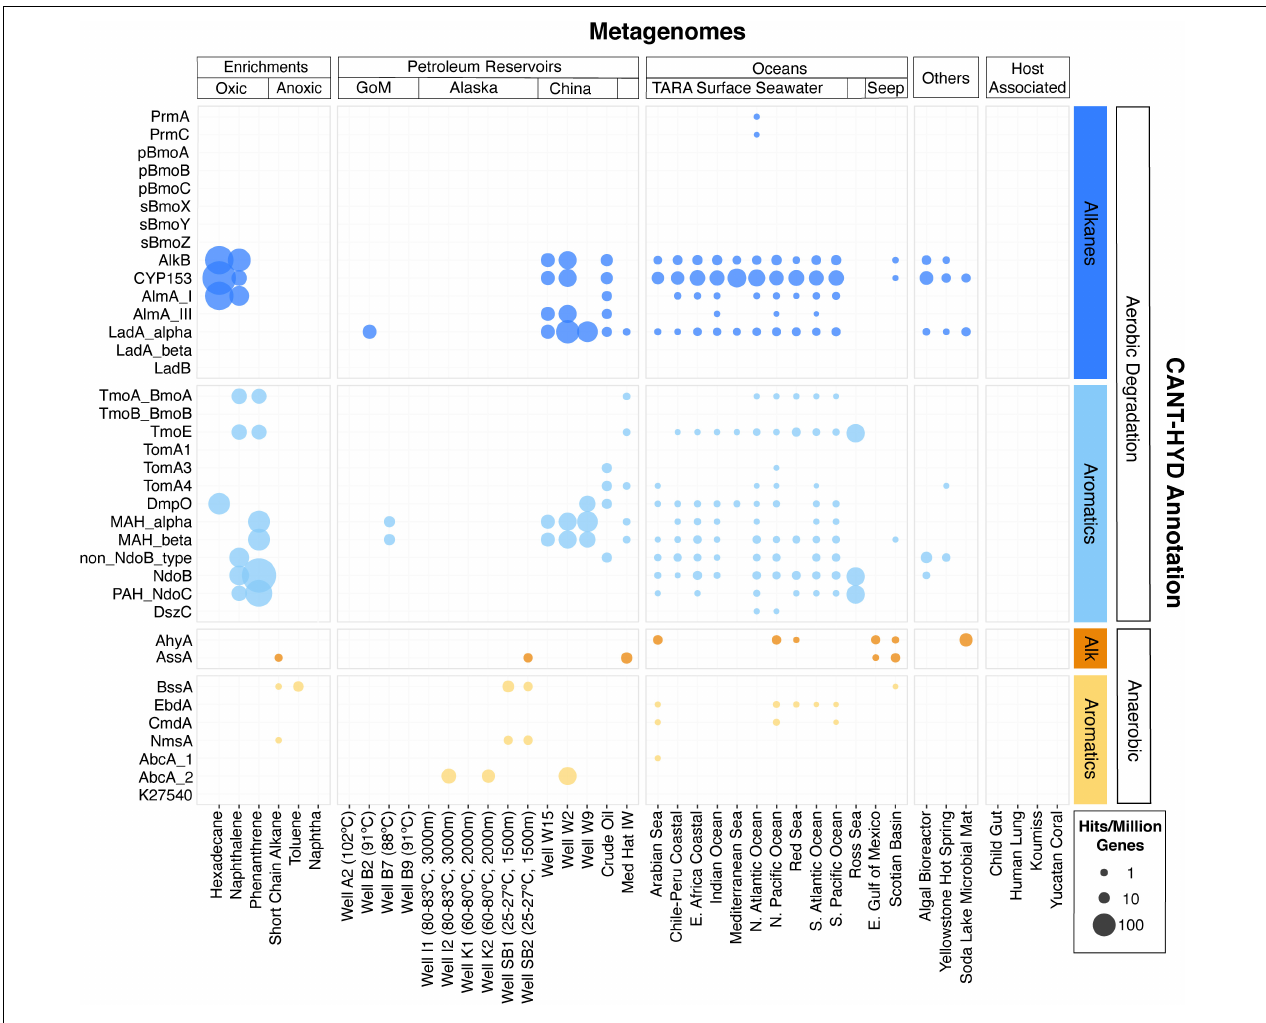
FIGURE 6 | Metagenomes from diverse environments analyzed with the CANT-HYD HMMs. CANT-HYD HMM hits (scores ≥ noise cutoff) (y-axis) to each metagenome (x-axis) normalized to per million protein coding genes. The size of the bubble depicts proportion of hydrocarbon degrading genes to total genic content of the metagenome. The metagenomes (x-axis) are grouped under Enrichments (hydrocarbon-degrading enrichment cultures), Petroleum Reservoirs (produced well water from petroleum reservoirs from Alaska, Gulf of Mexico, Jiangsu and Qinghai, China, and Medicine Hat, Alberta), Oceans (cold seeps, TARA surface seawater), Host-Assoc (host-associated microbiomes), Other: (other environments). The CAN-HYD HMMs are grouped by hydrocarbon substrate (alkane and aromatic) and respiration (aerobic and anaerobic). See Supplementary Table 4 for details regarding these metagenomes.